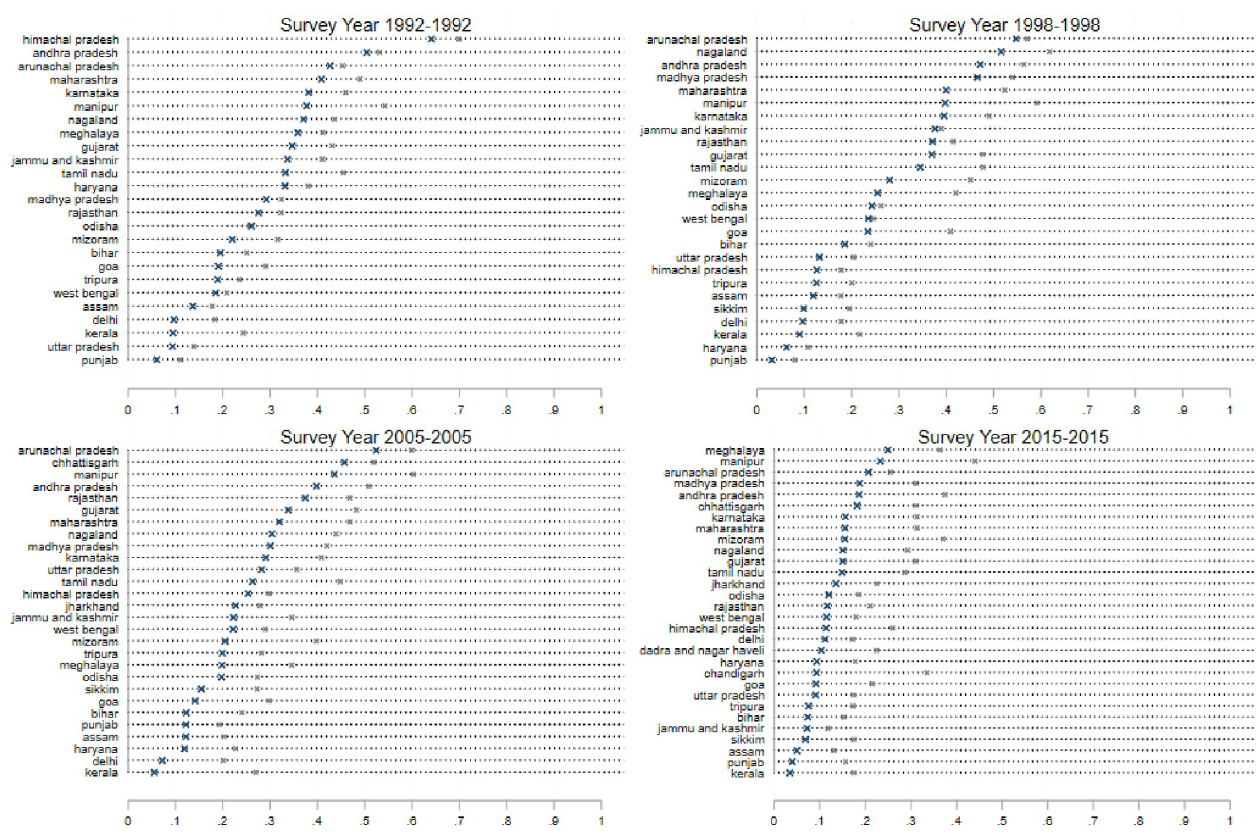
Fig 5. State level breakdown; employment; percentage of women married, ages 18–24 (marked as × ) and age Age25+ (marked as � ).